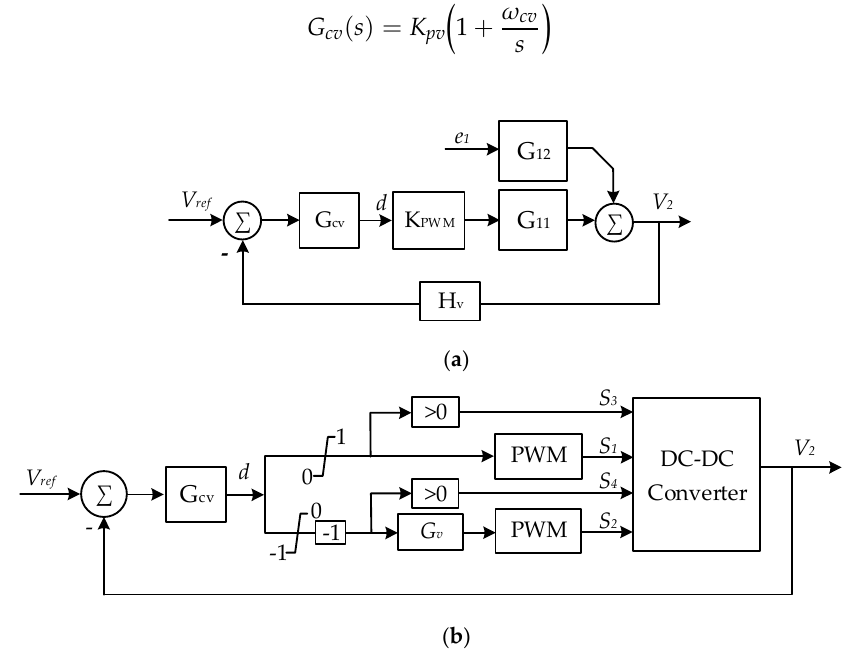
Figure 15. Voltage controller block diagram of the proposed converter. ( a ) Closed-loop small-signal model based on the discharge mode parameters as reference; ( b ) plant model.